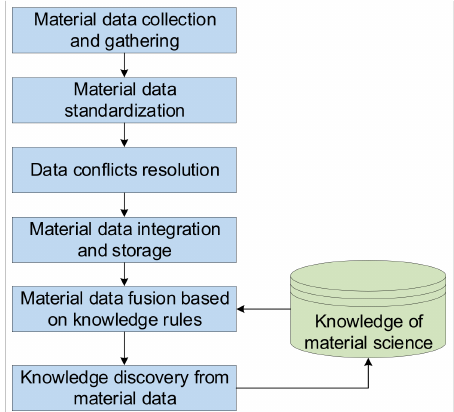
Figure 1. General process of multi-source material data